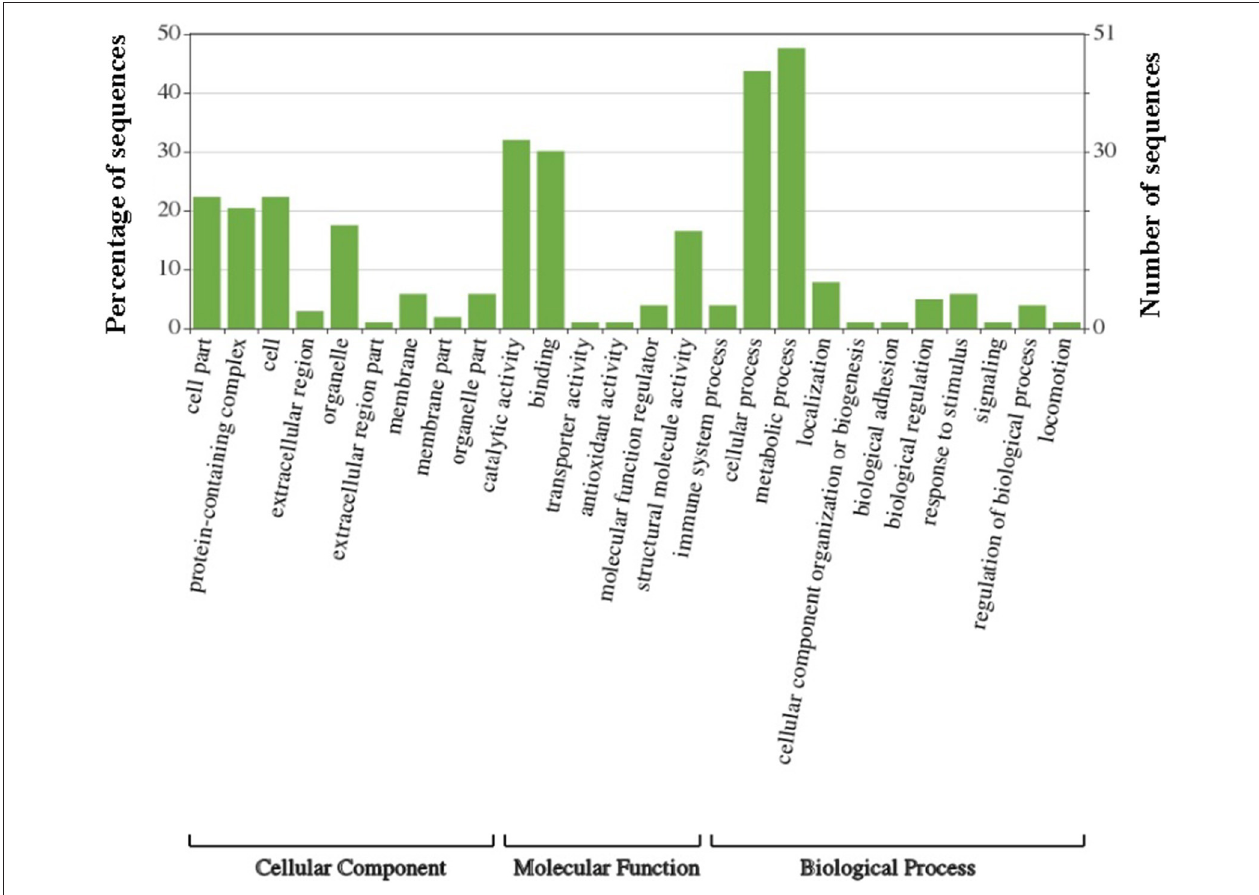
FIGURE 2 | Gene Ontology analysis of G. adiacens secreted proteins. Gene ontology annotation was achieved using Blast2GO and an online software “WEGO.” Protein sequences were grouped into 3 categories based on their properties and functions.